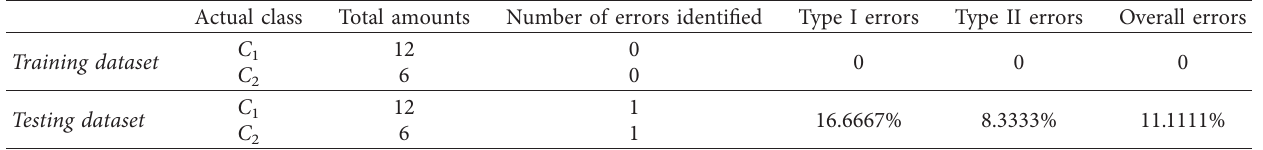
Table 5: Error summary with the SM-UTADIS